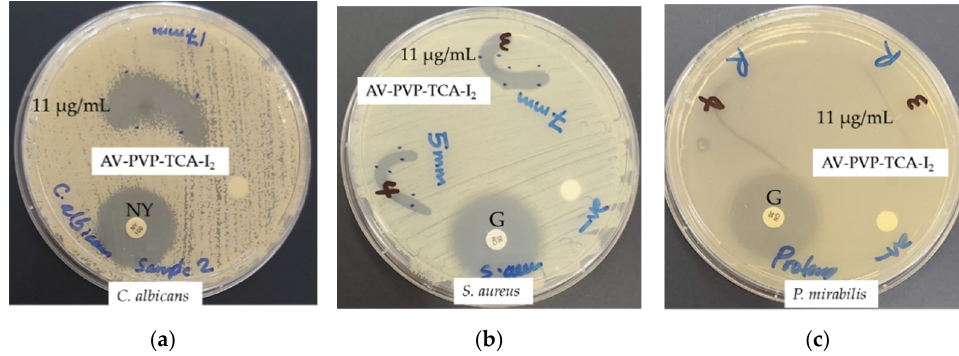
Figure 10. Impregnated, sterile PGA sutures with AV-PVP-TCA-I 2 . with positive control antibiotic nystatin (NY = 100 IU) and gentamicin (G = 30 µg/disc). From left to right: AV-PVP-TCA-I 2 (11 µg/mL) against ( a ) C. albicans WDCM 00054; ( b ) S. aureus ATCC 25932; ( c ) P. mirabilis ATCC 29906.